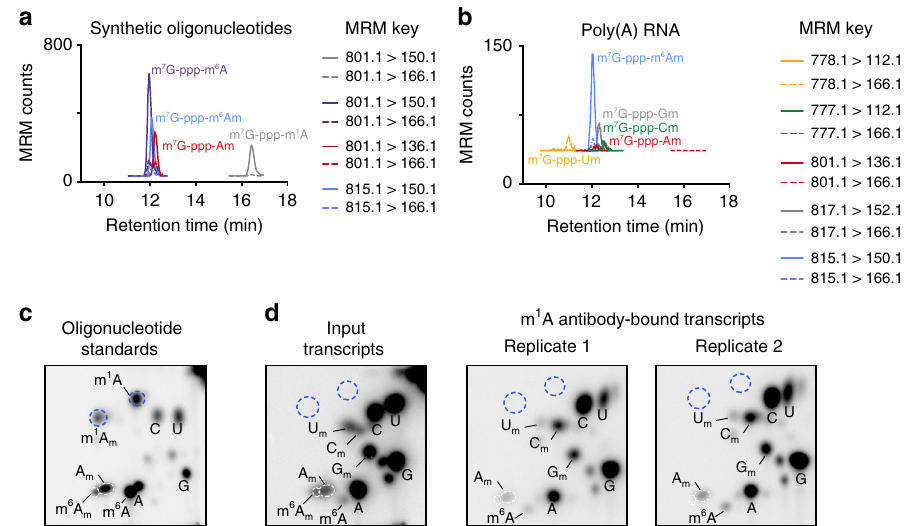
Fig. 3 The AMA-2 m 1 A antibody does not enrich for a novel m 1 A-containing cap structure. a Detection of synthetic 5 ′ cap dinucleotides using mass spectrometry. Dynamic multiple reaction monitoring (dMRM) chromatograms were recorded in positive ion monitoring. Injected was a mixture of oligonucleotides containing m 7 G-ppp-m 6 A m , m 7 G-ppp-m 1 A, m 7 G-ppp-m 6 A, or m 7 G-ppp-A m cap structures. Two MRM transitions were recorded for each standard (indicated in key in fi gure). Note the permanent positive charge on the adenine base of m 7 G-ppp-m 1 A resulted in an increased retention time on the ANP resin as expected. Thus, the m 7 G-ppp-m 1 A m dinucleotide would be expected to elute at a retention time later than m 7 G-ppp-m 6 A due to the permanently positive charged adenine, and earlier than m 7 G-ppp-m 1 A due to the additional methyl group on the ribose. b Detection of 5 ′ cap dinucleotides from cellular mRNA using mass spectrometry. Dynamic multiple reaction monitoring (dMRM) chromatograms were recorded in positive ion monitoring. Injected were mRNA samples from HEK293T cells. Two MRM transitions were recorded for each cap structure of interest (indicated in key in fi gure). We searched for peaks containing MRM transitions and retention times re fl ecting m 7 G-ppp-m 1 A or m 7 G-ppp-m 1 A m (see note in a ), but no such signal was detected. c 2D-TLC analysis of capped oligonucleotide standards containing various modi fi ed adenines as initiating nucleotides. The migration properties of these various initiating nucleotides are indicated (here, the initiating nucleotides include m 1 A, m 1 A m , A m , m 6 A, and m 6 A m ). Spots re fl ecting A, C, G, and U are also marked. Unmarked spots most likely re fl ect RNA dinucleotides that are not completely digested during RNA preparation 45 . d 2D-TLC analysis of mRNA extended caps in antibody-unbound (left panel) or m 1 A antibody-bound poly(A) RNA. Known identities of detected spots are marked. Expected positions of potential m 1 A or m 1 A m -initiating nucleotides are marked (blue dashed circles) based on standard migrations in We analyzed the transcription-start nucleotide of poly(A) RNA and poly(A) RNA enriched with the m 1 A antibody by 2D-TLC.